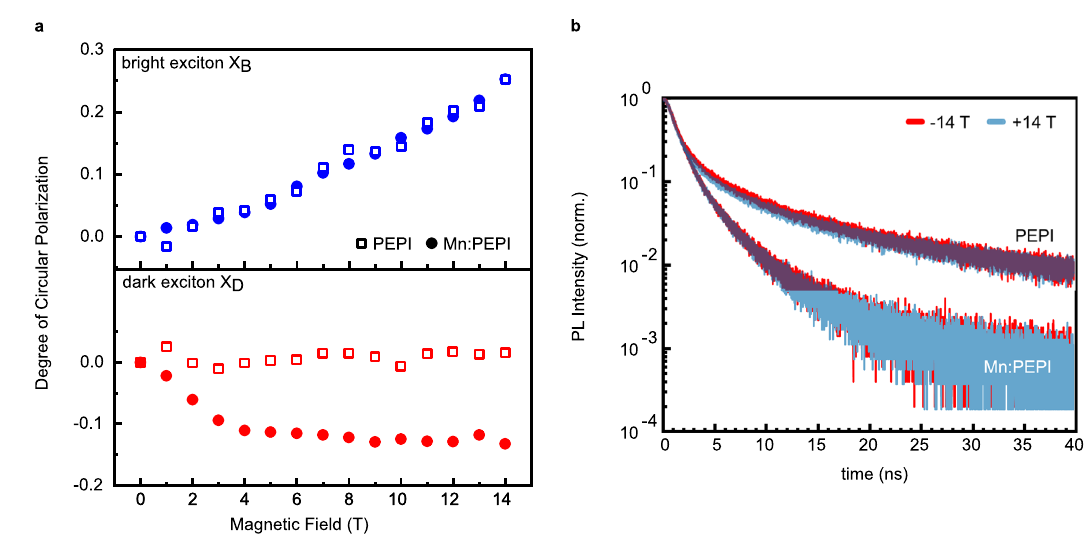
Fig. 3 Circular PL polarization of PEPI and Mn:PEPI. a Comparison of undoped PEPI and magnetically-doped Mn:PEPI for the bright (top) and dark (bottom) exciton emission. b PL kinetics for opposite fi eld directions, probing the dynamics of circularly polarized